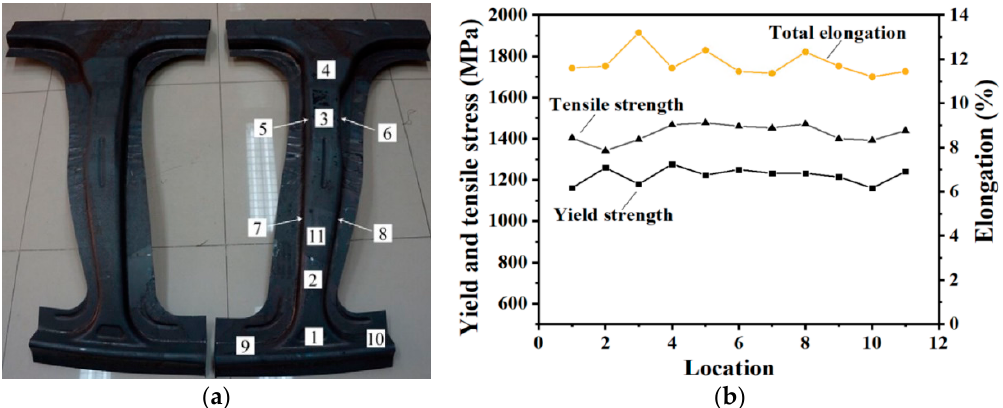
Figure 15. Low-temperature hot stamping of MMn steel component: ( a ) Low-temperature hot stamped B-pillar [126]; The numbers show the positions on the hot stamped B-pillar selected for testing of mechanical properties. ( b ) Mechanical properties (tensile strength, yield strength and elongation) at corresponding locations [126]. Adapted from [126], with permission from Elsevier, 2020.